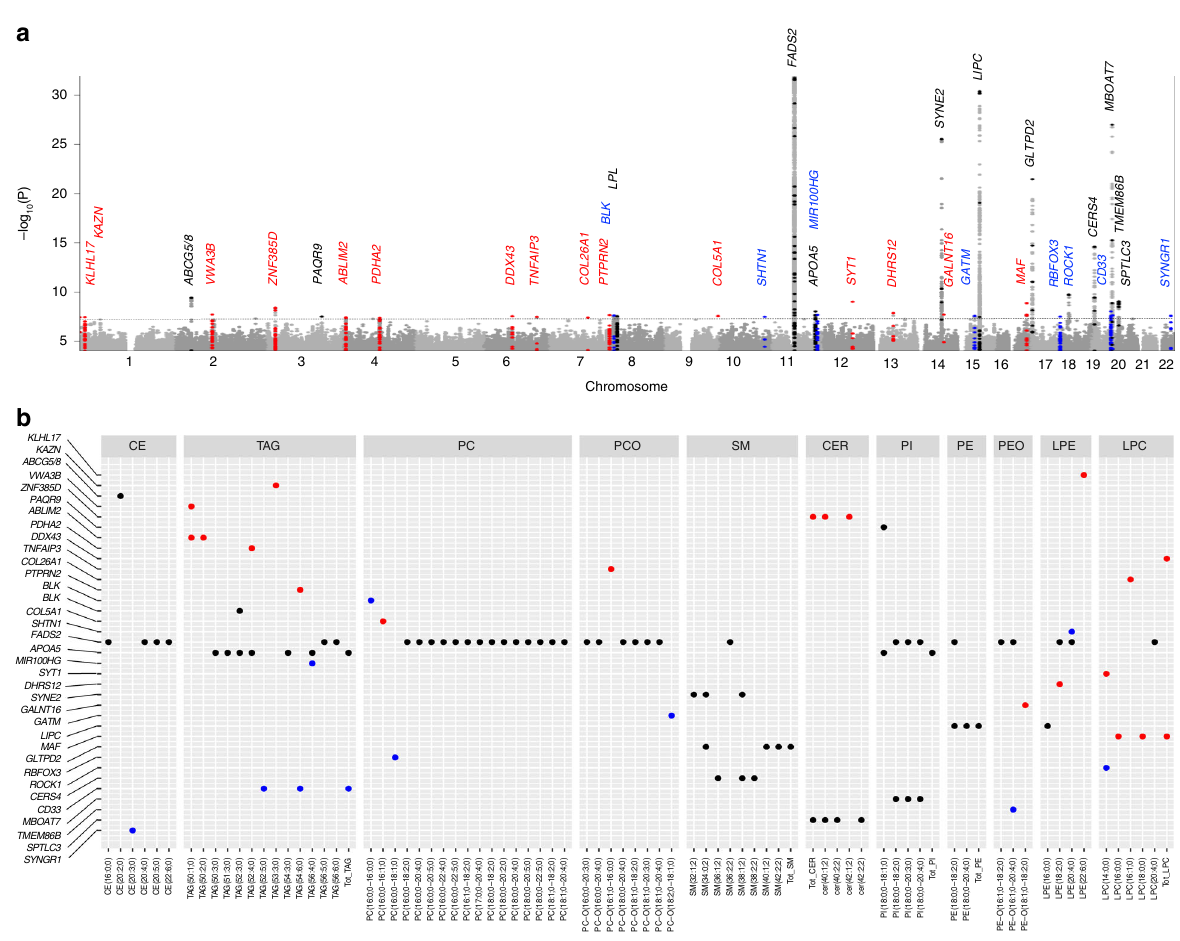
Fig. 4 Genetic architecture of the lipidome. a Manhattan plot showing associations for all 141 lipid species. Only the associations with P < 1.0 × 10 − 4 in the meta-analysis and consistent in directions in all three batches are plotted. The y -axis is capped at − log10 P- value = 30 for better representation of the data. The dotted line represents the threshold for genome-wide signi fi cant associations at P < 5.0 × 10 − 8 . b Genome-wide signi fi cant associations between the identi fi ed lipid species-associated loci and lipid species showing effect of the loci on the lipidome. The plotted P- values were calculated from the meta- analyses using the inverse variance weighted method for fi xed effects. New hits with P < 5.0 × 10 − 8 are shown as red dots, new independent hits in previously reported loci are presented as blue dots and hits in previously known loci are presented as black dots